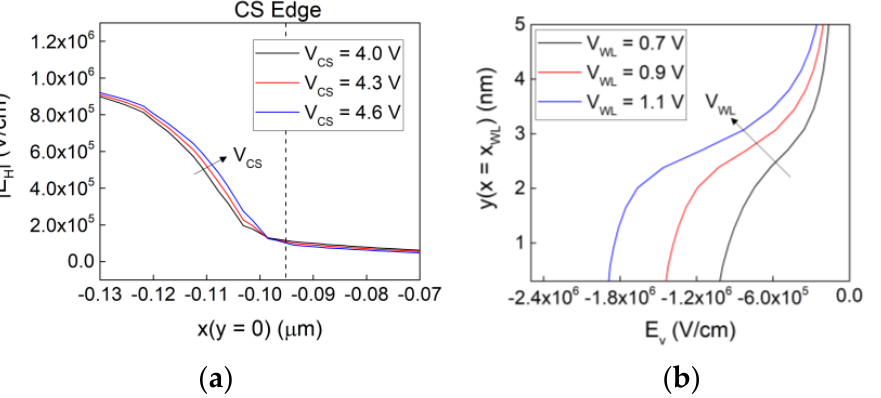
Figure 13. TCAD simulations of: ( a ) the horizontal component of the electric field (in absolute value) against the x coordinate in y = 0, at the CS edge with V CS as a parameter; ( b ) the vertical component of the electric field against the y coordinate in x = X WL , between the SiO 2 interface and the WL electrode with V WL as a parameter.